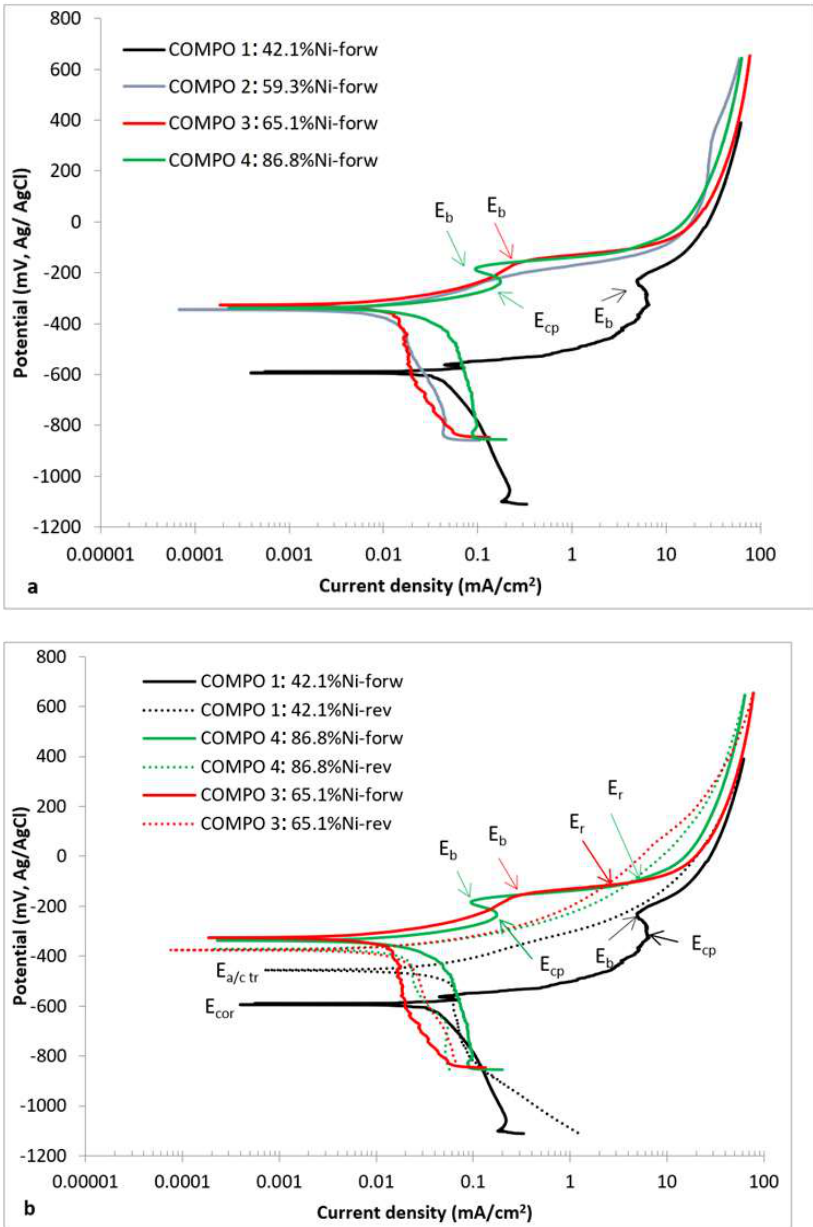
Figure 9. Effect of Ni content in the initial feedstock on the cyclic polarization behavior of nickel aluminide coatings. ( a ) Forward polarization curves; ( b ) cyclic (forward and reverse) polarization curves (3.5% NaCl, 25 °C).